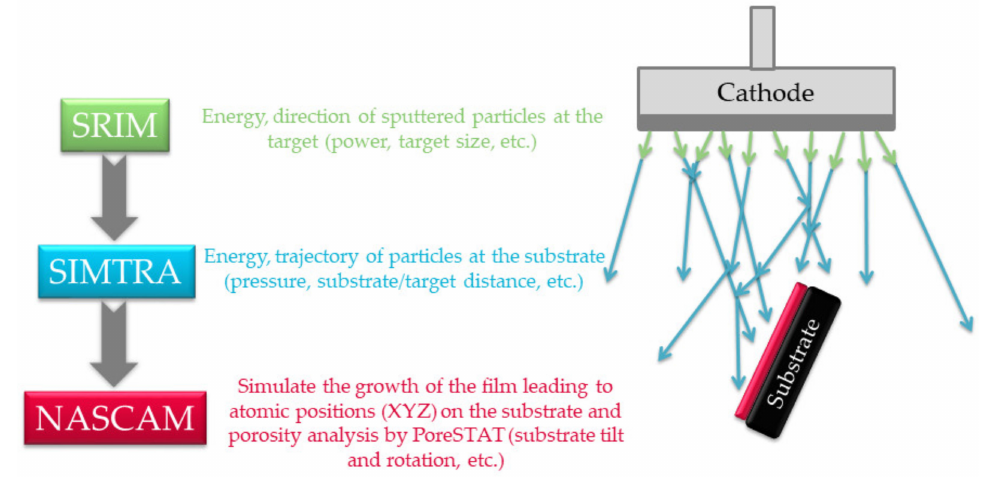
Figure 3. Kinetic Monte Carlo simulation